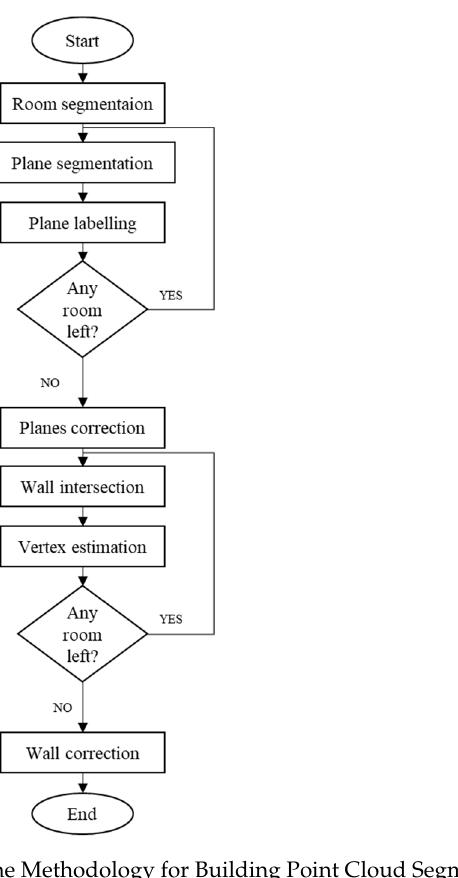
Figure 1. Flow Chart Diagram of the Methodology for Building Point Cloud Segmentation.